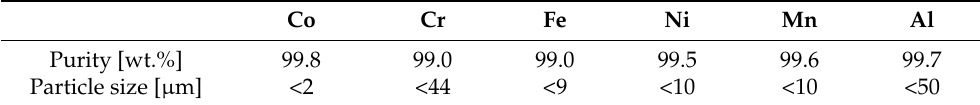
Table 1. Characteristic of element